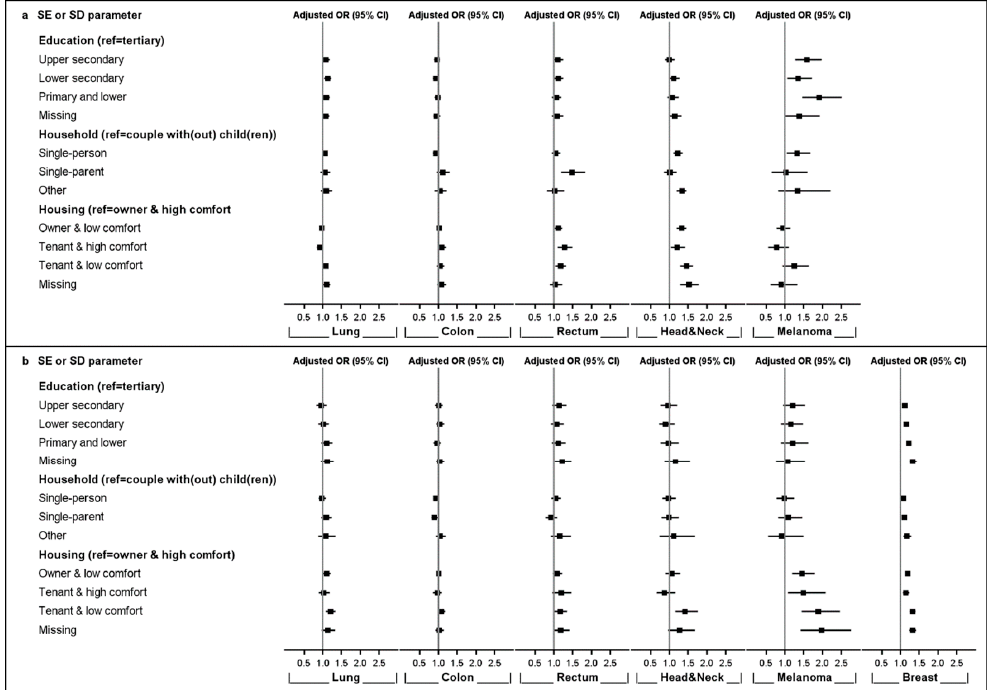
Figure 3. Adjusted odds ratios (ORs) with a 95% confidence interval (CI) for being diagnosed with advanced stage among known stages by socio-economic (SE) or -demographic (SD) parameters, cancer type, and sex; 2004–2013. Upper panel ( a ): men; lower panel ( b ): women.